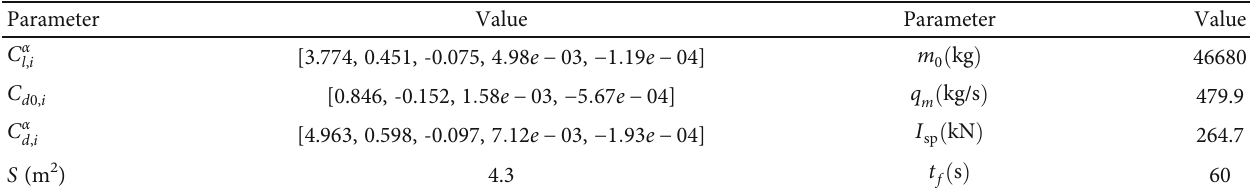
Table 1: Parameter of the vehicle